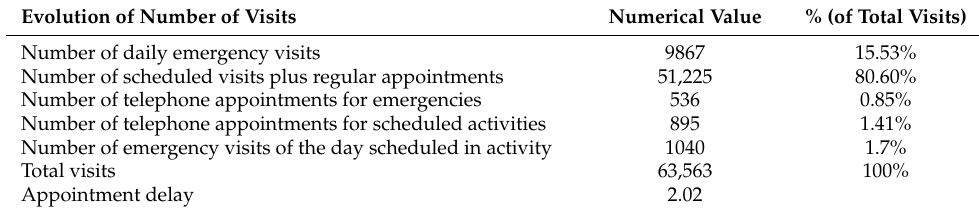
Table 6. 2020 measurement